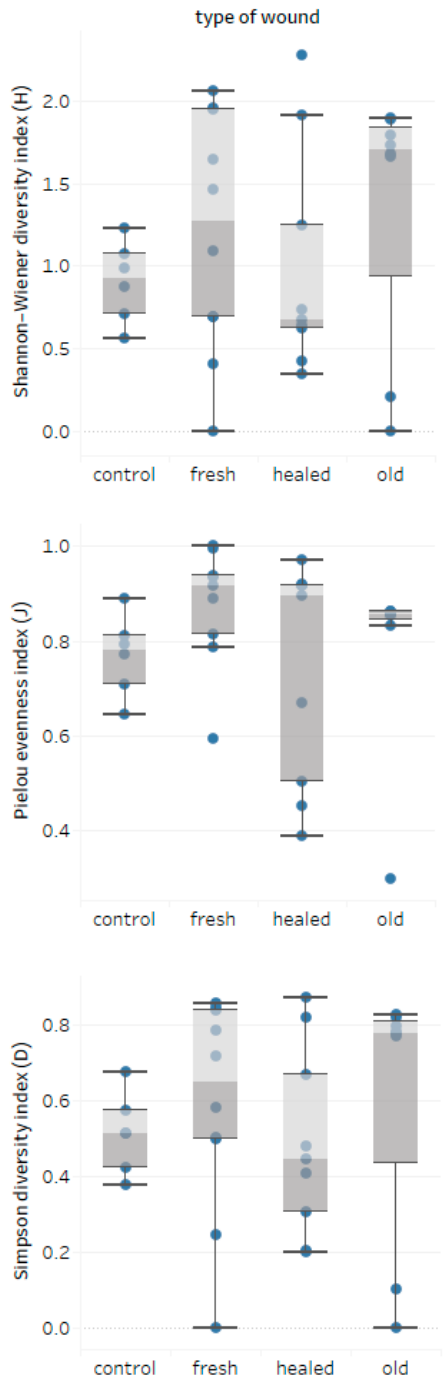
Figure 7. Box-plot representation of the biodiversity in three types of wounds of fir trunk, based on α -diversity indexes: Shannon-Wiener diversity index (H), Pielou evenness index (J) and Simpson diversity index (D).